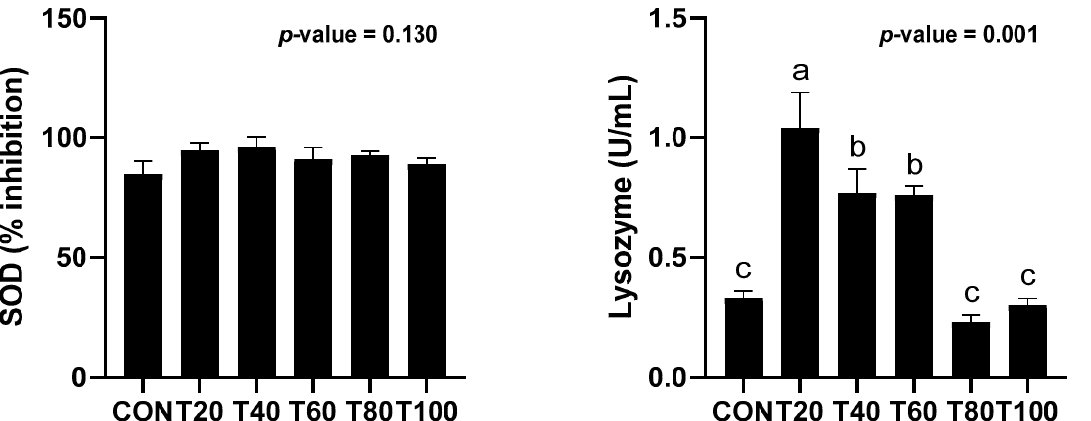
Figure 1. Non-specific immune responses of juvenile rainbow trout fed experimental diets for 8 weeks. Values are means from triplicate groups of fish where the values in each row with different